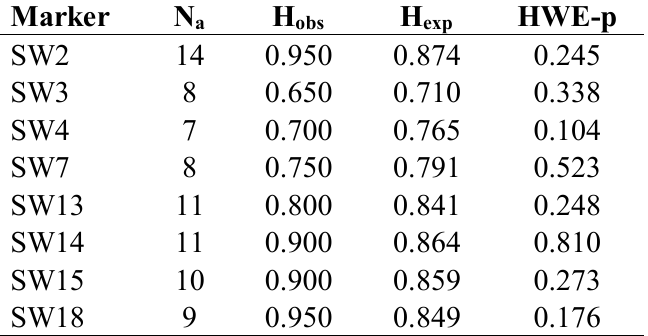
Table 2. Variation across 8 microsatellite loci in a population of 20 Sinanodonta woodiana individuals. N : number of alleles; H : observed heterozygosity; H a obs heterozygosity; HWE-p: p- value of chi square test for Hardy-Weinberg